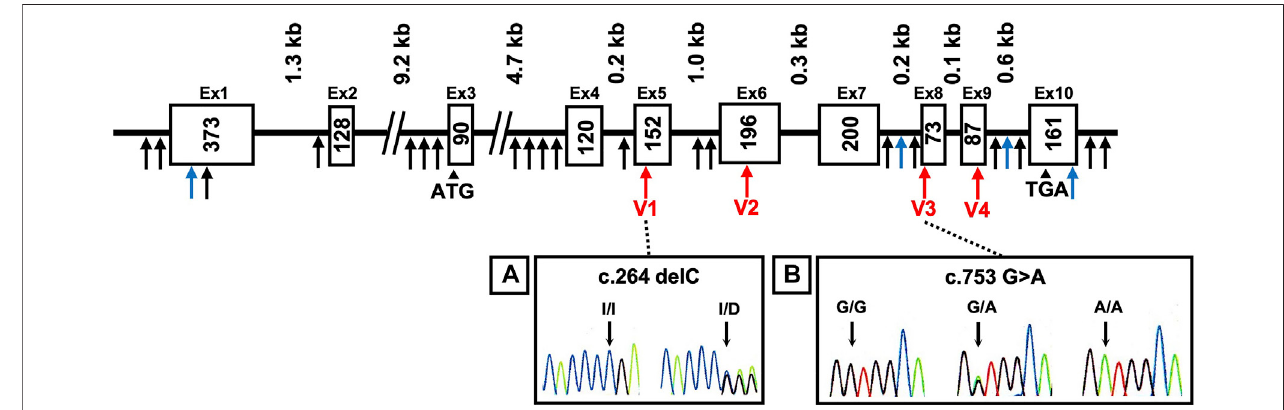
FIGURE 1 | DNA sequence chromatograms showing frameshift mutation and variants. Novel variants (blue arrows), variants in coding regions shown in Table 1 (V1 – V4variants: red arrows),and others(black arrows)areshown.Heterozygoussequencetraces derivedfrom individuals carrying (A) acytosinedeletion withinexon5 (V1 variant) and (B) a mutation from guanine to adenine at the fi rst position of exon 8 (V3 variant). Sequencing analyses revealed normal (denoted I/I or G/G) and mutant (denoted delC or G > A) sequences; kb indicates the kilobase pairs. WT,